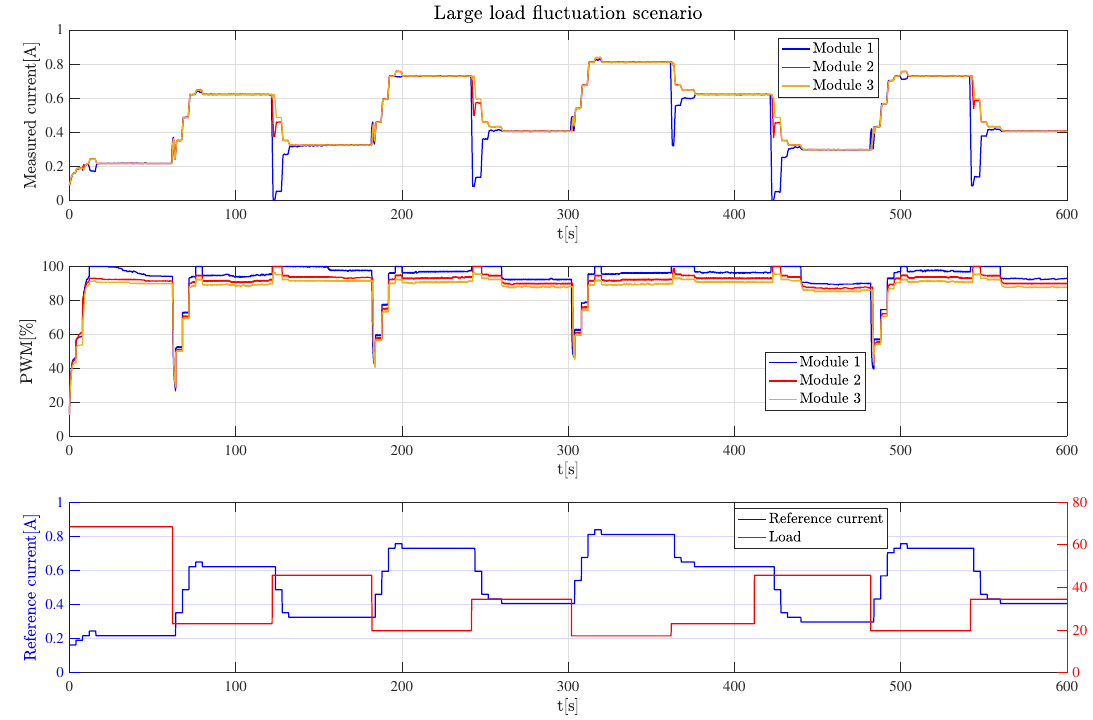
Figure 10. Currents ( top ) and modulation of battery voltages ( middle ) in battery modules for autonomous module current scheduling of three parallel placed battery modules with same battery capacity, reference current and time-varying external load impedance ( bottom ) under large load fluctuation